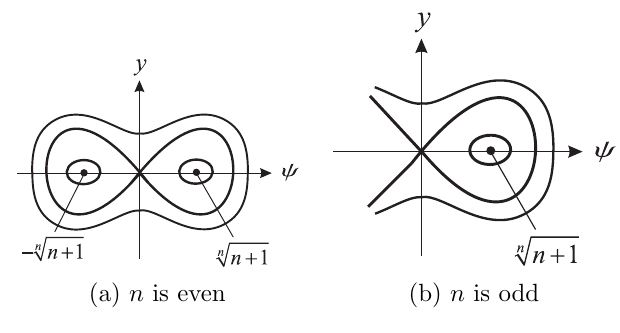
Figure 1. The phase portrait of system